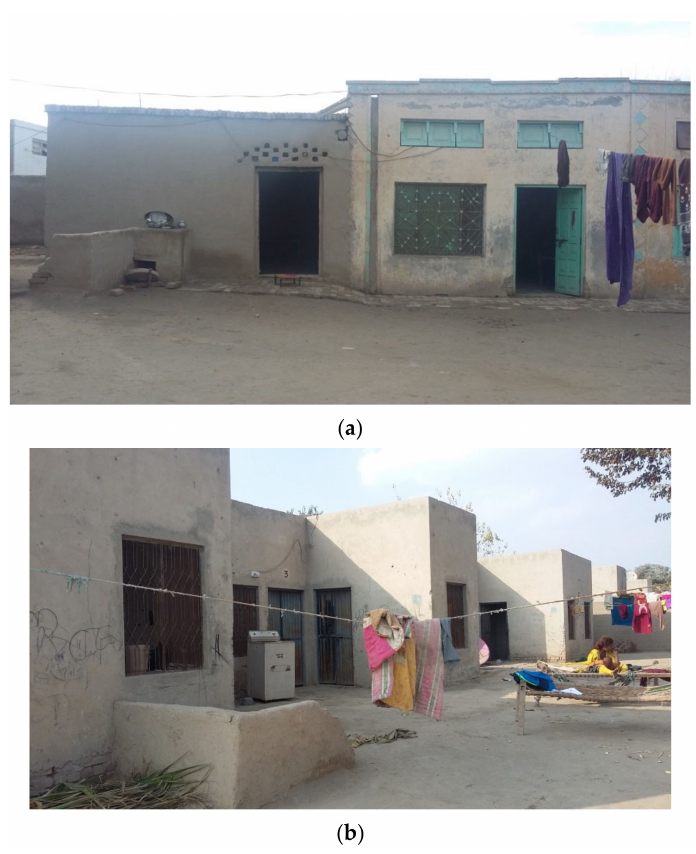
Figure 8. ( a ): A repaired house by an old respondent in LN, district Layyah. ( b ): Rebuilt houses in a row for one of the villages of union council, LN, district Layyah.